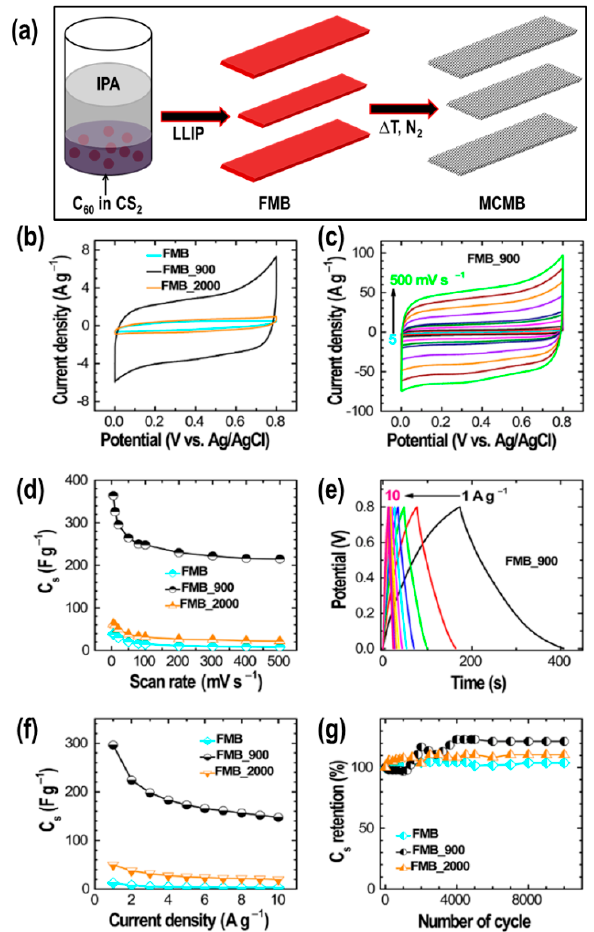
Figure 1. ( a ) Illustration of fullerene C 60 microbelts (FMBs) crystals synthesis and their conversion into mesoporous carbon microbelts (MCBs), ( b ) Cyclic voltammograms (CV) of the prepared materials at a fixed scan rate of (5 mV s − 1 ), ( c ) CV curves vs. scan rate as a typical example of the optimal sample (FMB_900). ( d ) Comparison of calculated specific capacitance of prepared samples (FMB, FMB_900, and FMB_2000). ( e ) Typical example of charge − discharge (CD) curves vs. current density (1 − 10 A g − 1 ). ( f ) Variation of calculated specific capacitance vs. current densities showing the high rate performance of mesoporous carbon microbelts, and ( g ) Capacitance retention up to 10,000 charge − discharge cycles. Reproduced from Reference [109]. Copyright American Chemical Society, 2017.